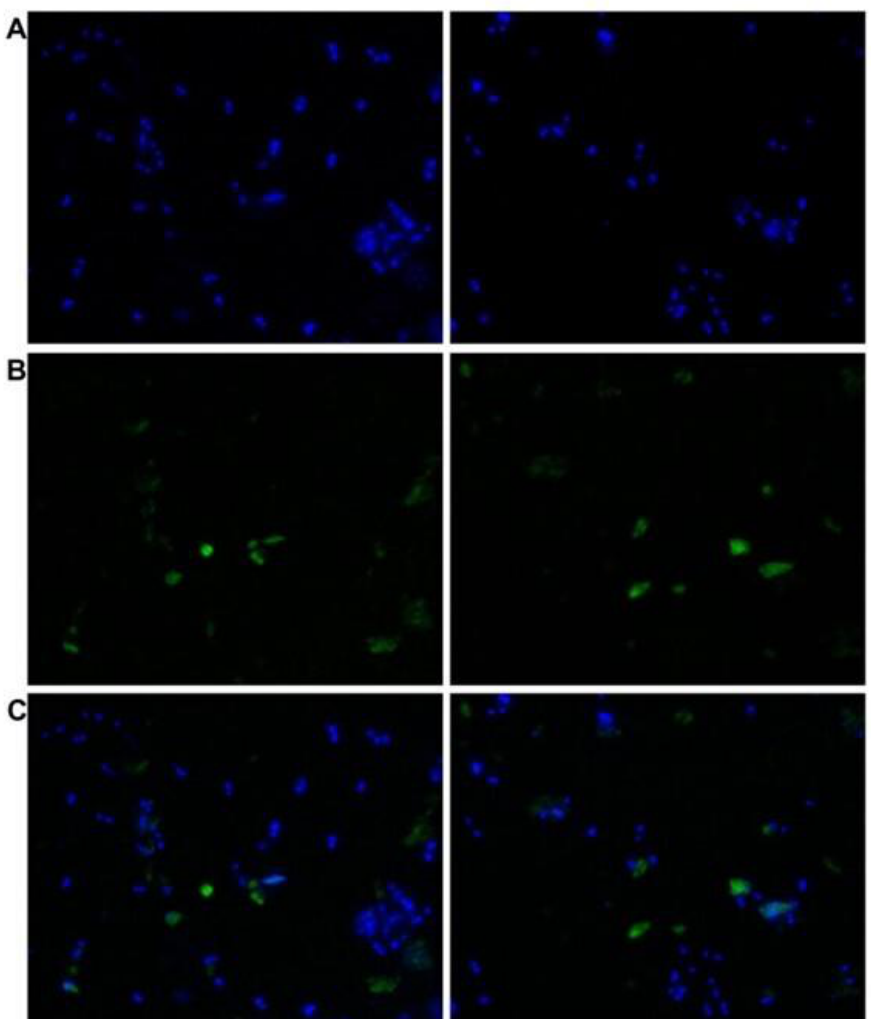
Figure 4. Indirect immunofluorescent staining of L. infantum promastigotes smeared on glass slides with human TGase 2 rabbit polyclonal antibodies (orb2986) and FITC-tagged anti-rabbit antibodies. FITC fluorescence was visualized using a Nikon Microphot FXA fluorescent microscope (×40 magnification). ( A ) DAPI-stained nuclei of the parasites. ( B ) FITC labelling. ( C ) Merged image of A and B.